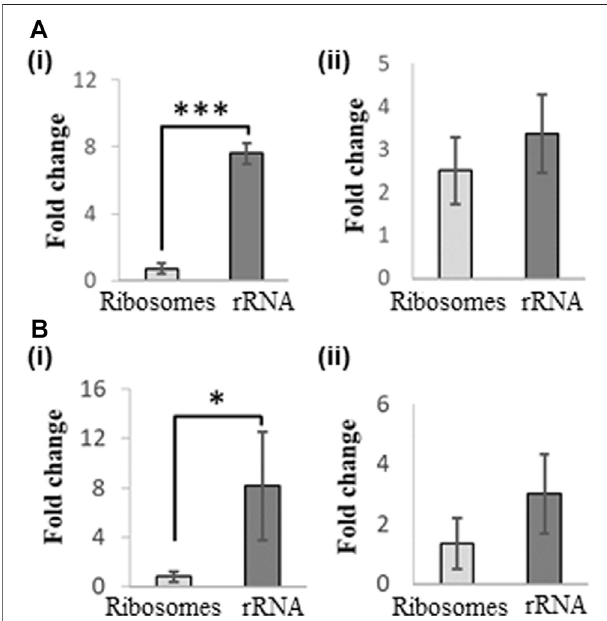
FIGURE 2 | Changes in levels of adenosine oxidation products in rRNA following exposure of ribosome and rRNA to oxidative stress. (A) UVA- induced changes in levels of (i) 8-oxo-A, and (ii) FapyA. (B) Fenton-reaction induced changes in levels of (i) 8oxo-A, and (ii) FapyA. Fold change was expressed as the ratio of signal observed between exposed and unexposed samples following normalization against internal standard 5 ′ bromo- 2 ′ deoxycytidine. Data are shown as the mean of fi ve independent samples ± SD. Statistical differences were determined using unpaired two-tailed t -test (* p < 0.05; *** p <